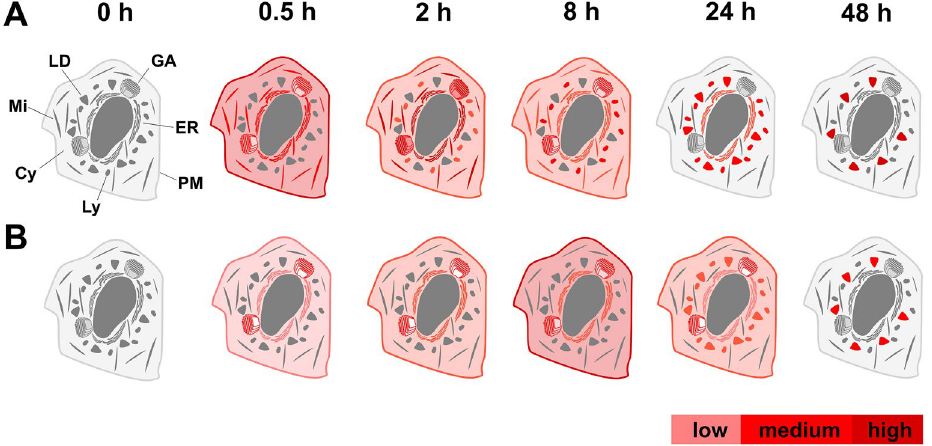
Figure 7. Schematic distribution of FP-24 ( A ) and FP-25 ( B ) signal in U2-OS